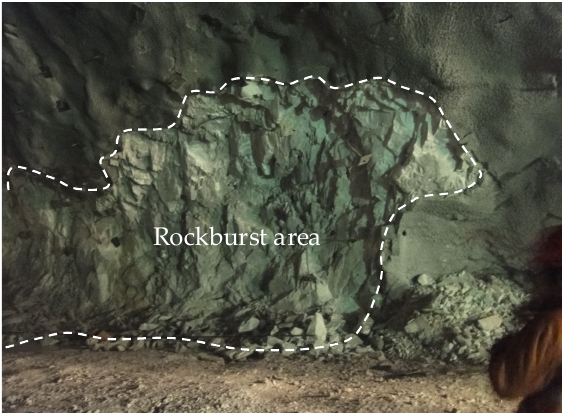
Figure 7. Photograph of the rockburst that occurred following the MS events recorded and analyzed in Test 1.